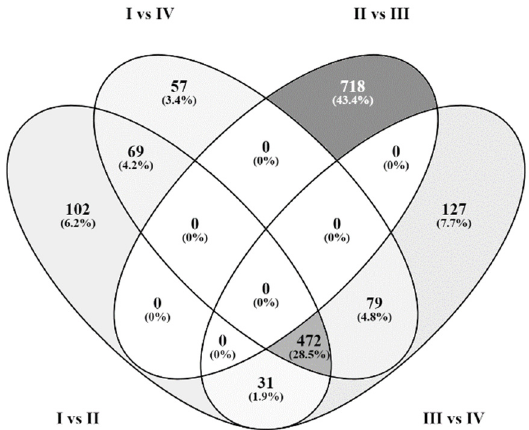
Figure 2. The Venn diagram showing the number of common DEGs in four comparisons when downregulated in: group I vs. group IV (5-AZA-dc versus TSA), I vs. II (5-AZA-dc versus 5-AZA- dc+TSA), II vs. III (5-AZA-dc+TSA versus control group), and III vs. IV (control group versus TSA).